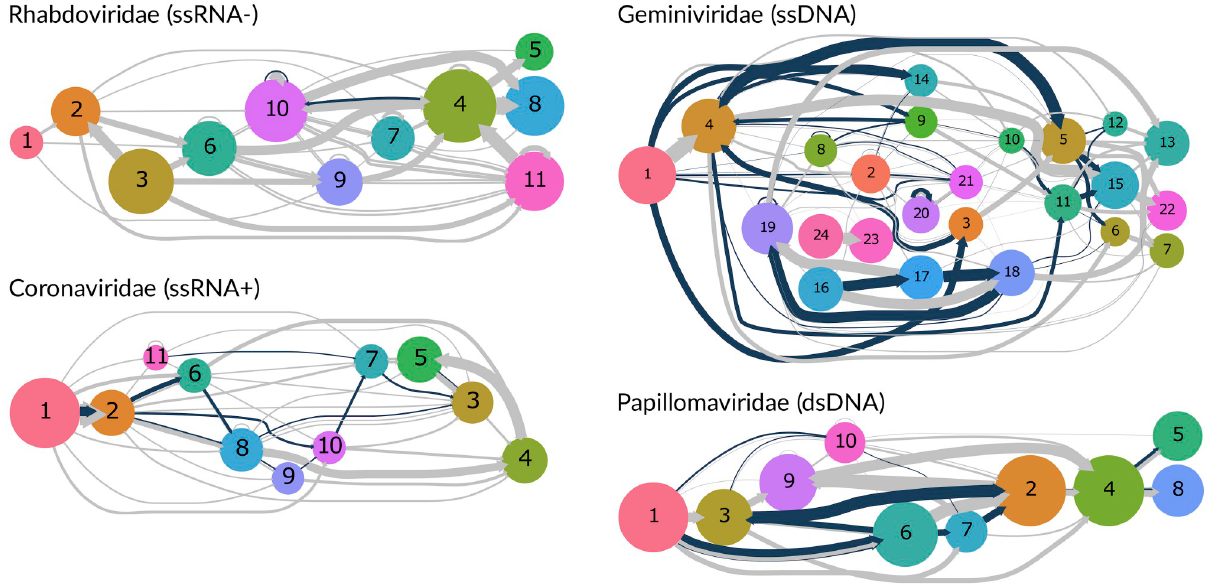
Fig 4. Adjacency graphs for different virus families. These graphs were generated from the clustered ORF data, using the same procedure that we employed to generate Fig 3 for Adenoviridiae. Blue edges indicate overlapping open reading frames, and grey edges represent ORFs that are adjacent but not overlapping. Edge widths were rescaled by a factor of 0.5 for Geminiviridae and Papillomaviridae to accommodate differences in sample size (numbers of genomes) among virus families. Arrowheads were manually adjusted in Inkscape as in Fig 3.